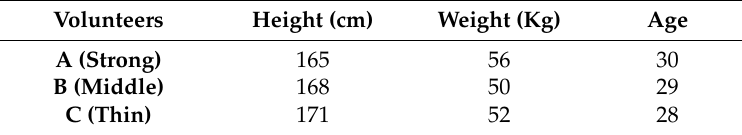
Table 1. The main parameters of the volunteers for the